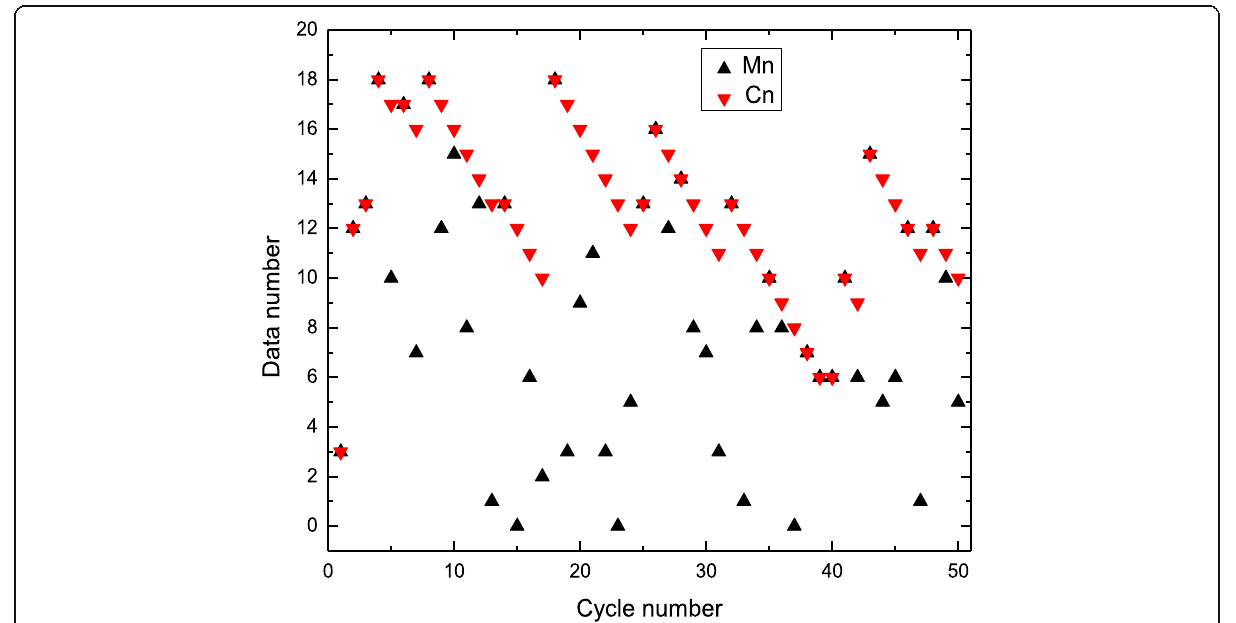
Fig. 40 The total volume of data randomly changes from 0 to 18; Mn and Cn in the first 50